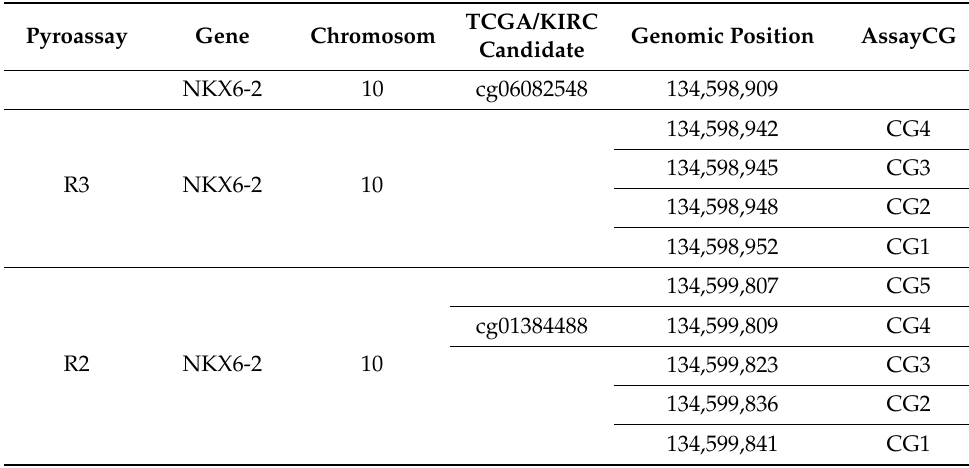
Figure 2. Genomic organization of NKX6-2 . Localization of exons (higher part of orange rectangles) and the 5 (cid:48) UTR and 3 (cid:48) UTR relative to genomic regions (lower part of orange rectangles), CpG sites annotated for the region (CpG sites), localization of the CpG island (CGI), positions of CpG sites considered in the TCGA KIRC study (KIRC), candidate CpG sites showing an association with the state of distant metastasis. Table 1. Genomic localization of CpG sites